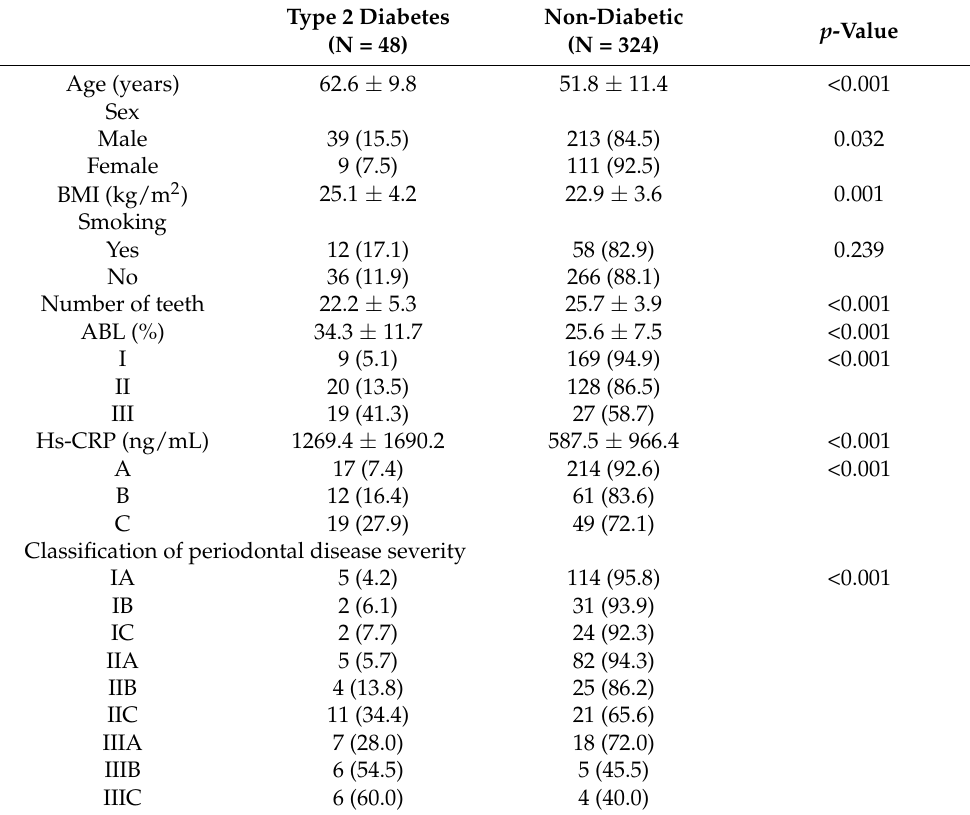
Table 1. The relationship between type 2 diabetes and other